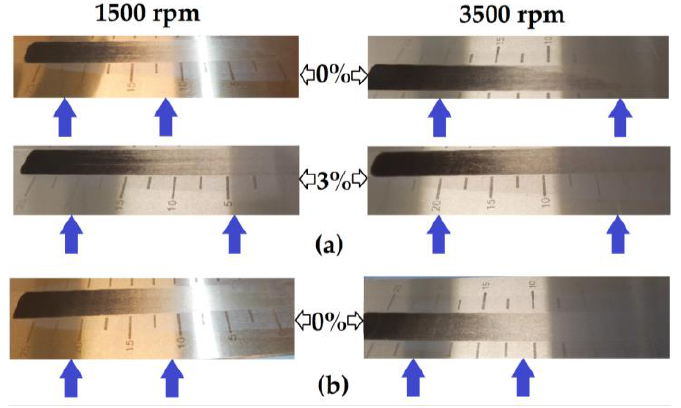
Figure 7. Hegman gauge tests of the slurries: ( a ) MTI hard carbon mixed at 1500 rpm and 3500 rpm; ( b ) Kuranode mixed at 1500 rpm and 3500 rpm.